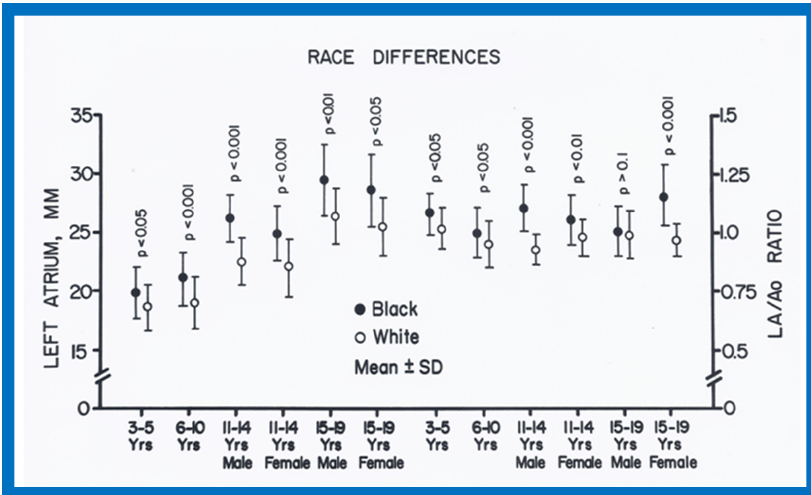
Figure 34. Race ‐ related differences in the measurements of left atrium (LA) and LA to aortic root (Ao) ratio are illustrated for black (filled circles) and white (unfilled circles) children. Means and standard deviations (SD) are shown. Note the larger ( p < 0.05 to < 0.001) LA and LA/Ao ratio in black than white children for all age groups. Reproduced from Rao P.S., Thapar M.K. [10].